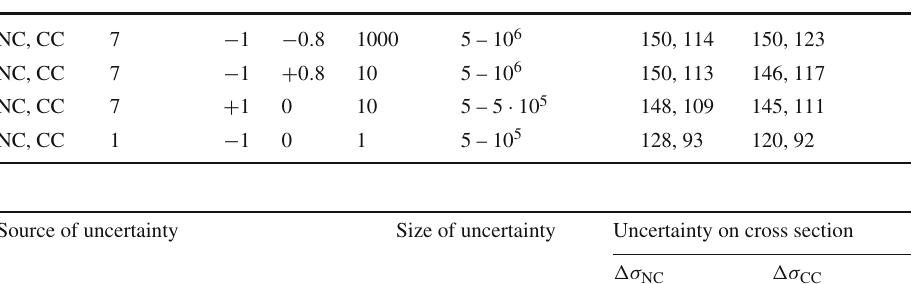
Table 1 Summary of data sets used in our analysis. Each set is simulated for the two electron beam energies E e = 50 GeV and 60 GeV